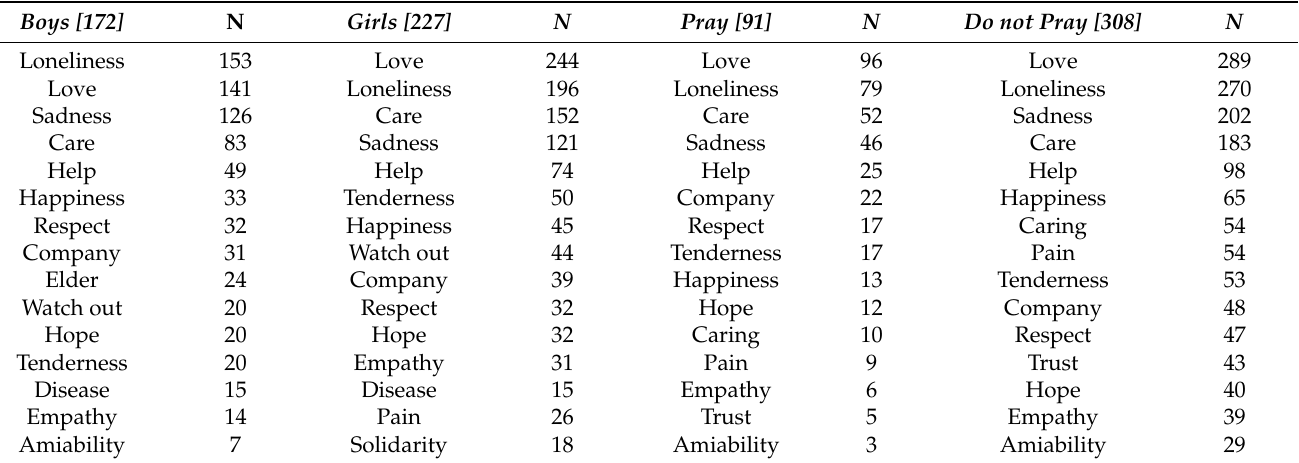
Table 4. Main word frequencies distributed in 4 clusters—boys, girls, pray, and do not pray—ordered by frequency of more to